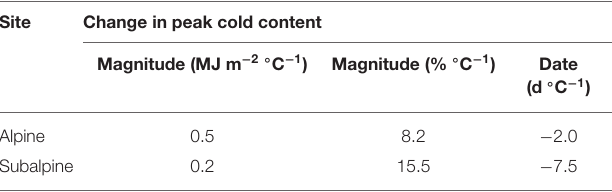
TABLE 4 | Same as Table 3 , but values correspond to changes in cold